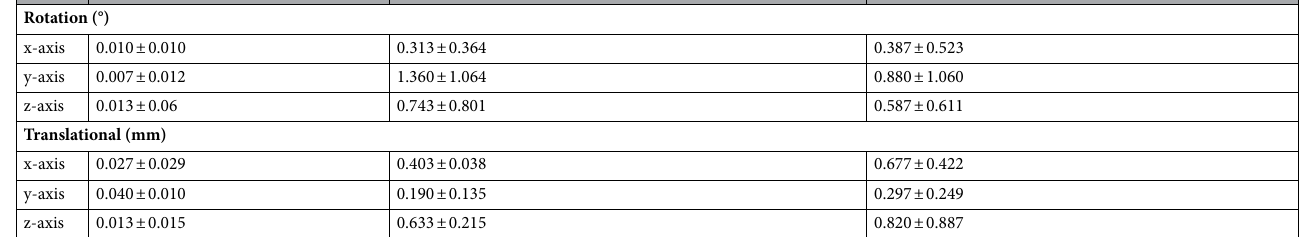
Table 1. The mean translational and rotational set-up errors in frameless fixation using fixed-AR. The setup errors for frameless fixation are based on virtual models followed by co-registration with planning CBCT. All data are shown as mean ± standard deviation.